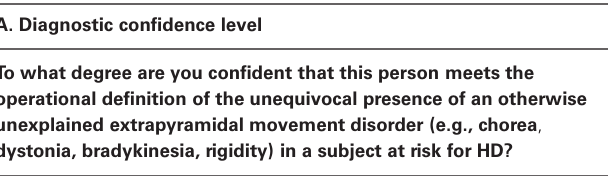
Table 1 | The Unified Huntington Disease Rating Scale diagnostic confidence level and Q80 diagnostic